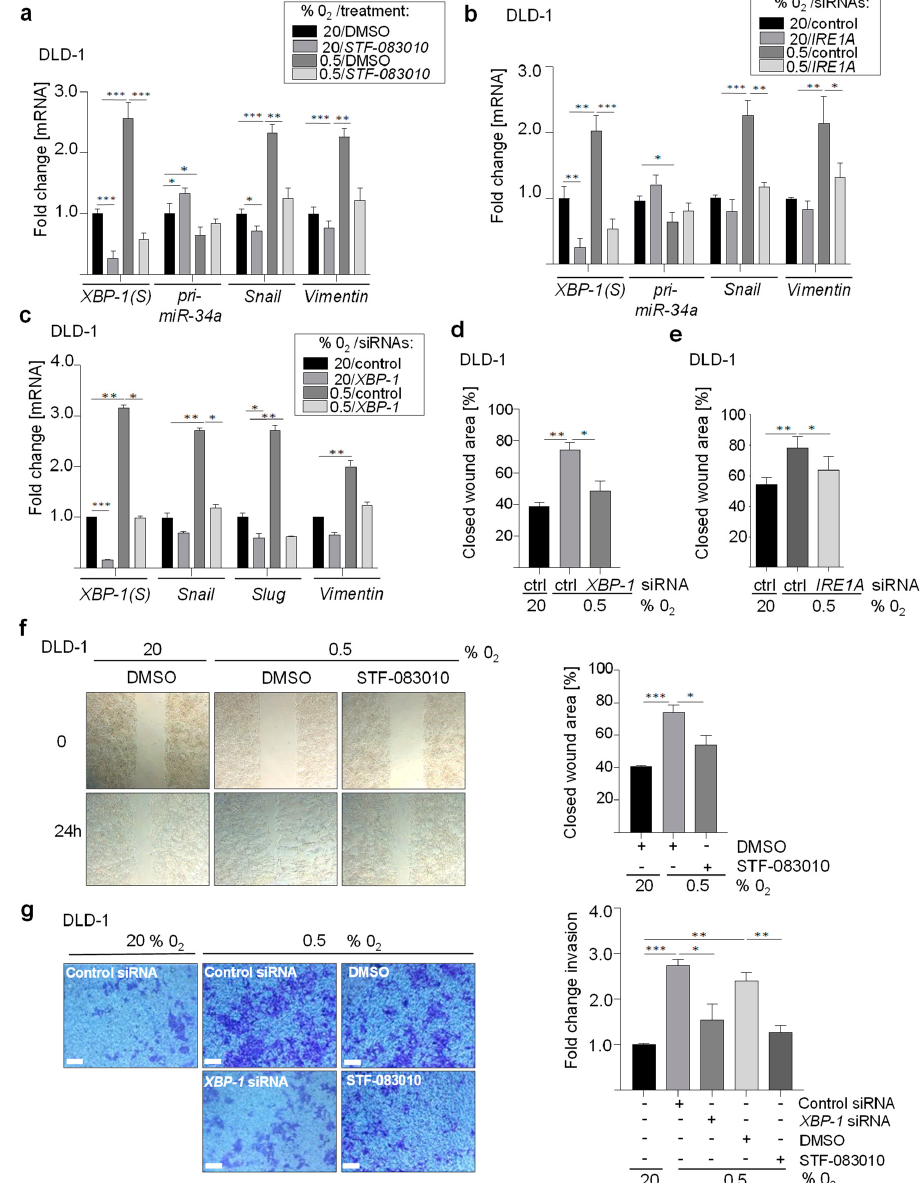
Figure 6. XBP-1(S) and IRE1A are required for hypoxia-induced EMT and invasion. ( a ) qPCR analysis in DLD-1 cells treated with DMSO or STF-083010 (60 µM) for 24 h, then cultured at 20% O 2 or 0.5% O 2 for 72 h. ( b ) qPCR analysis in DLD-1 cells transfected with IRE1A or control siRNAs and then cultured at 20% O 2 or 0.5% O 2 for 72 h. ( c ) qPCR analysis in DLD-1 cells transfected with XBP-1 or control siRNAs and then cultured at 20% O 2 or 0.5% O 2 for 72 h. ( d ) Densitometric representation of the wound-healing assay performed in DLD-1 cells transfected with XBP-1 or control siRNAs and then cultured at 20% O 2 or 0.5% O 2 . The normalized wound area was calculated using Image J software. ( e ) Densitometric representation of the wound-healing assay performed in DLD-1 cells transfected with IRE1A or control siRNAs and then cultured at 20% O 2 or 0.5% O 2 . The normalized wound area was calculated using Image J software. ( f ) Densitometric representation and phase-contrast images of the wound-healing assay of DLD-1 treated with DMSO or STF-083010 (60 µ M) and cultured at 20% O 2 or 0.5% O 2 for 72 h. The normalized wound area was calculated using Image J software. ( g ) Relative invasion in DLD-1 cells transfected with XBP-1 or control siRNAs, or treated with DMSO or STF-083010 (60 µ M) and cultured at 20% O 2 or 0.5% O 2 for 72 h. In panel ( a – g ) mean values ± SD (n = 3) are provided. (***) p < 0.001, (**) p < 0.01 (*), p <